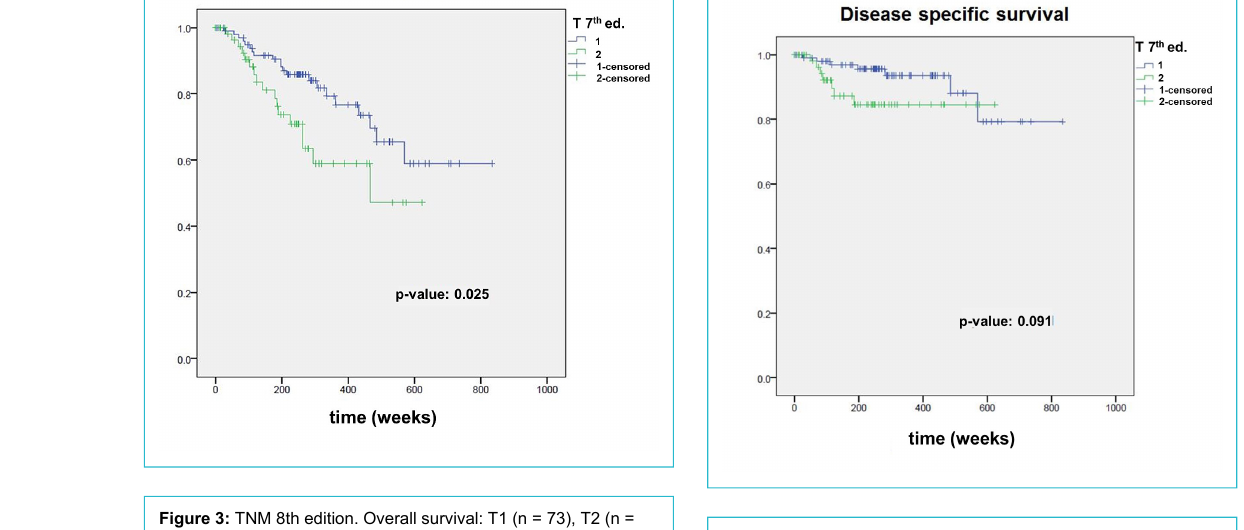
Figure 5: TNM 8th edition. Disease-specific survival: T1 (n = 73), T2 (n = 81) and T3 (n = 7); the difference between all the three curves is now